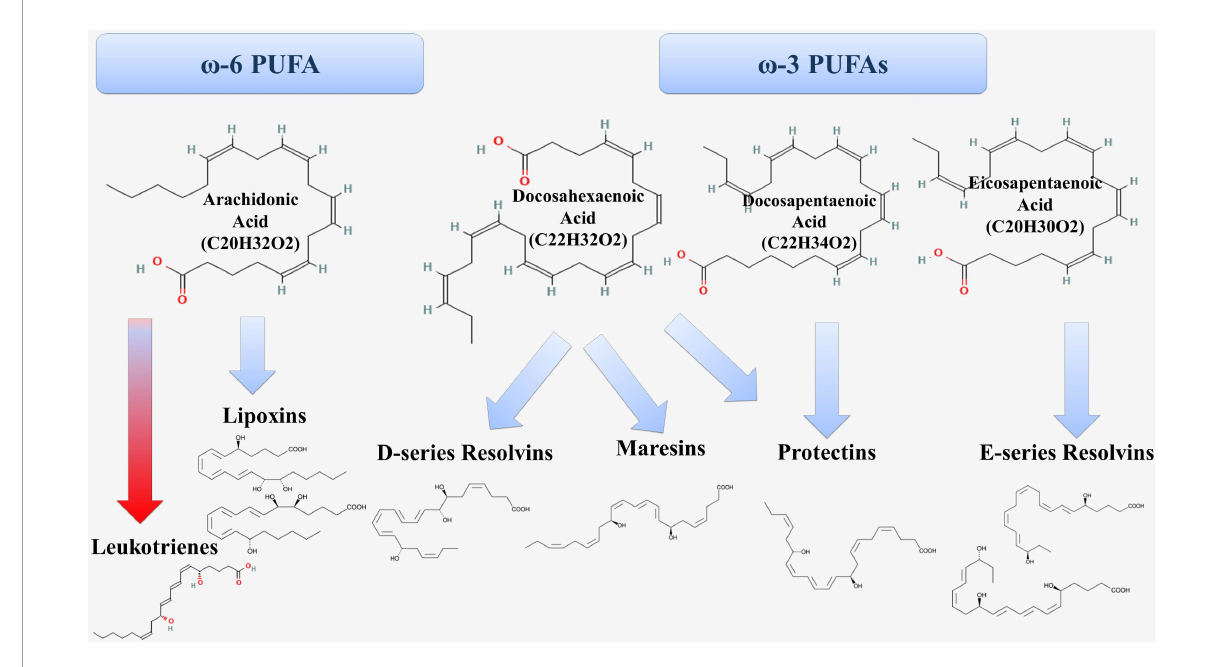
FIGURE3 Formation of proinflammatory (red arrow) and anti-inflammatory (blue arrow) lipid mediators from